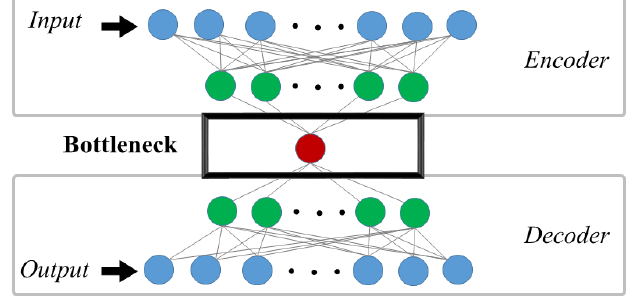
Figure 2. An illustration of a typical Autoencoder